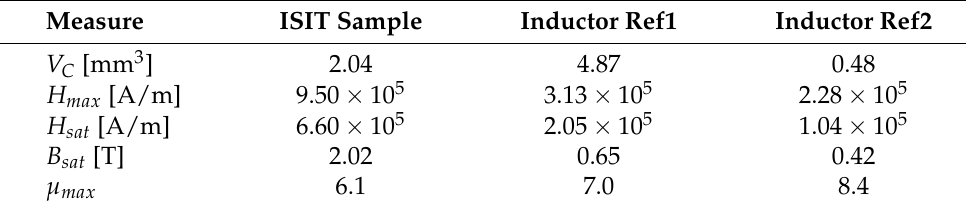
Table 3. Measurements of test samples at